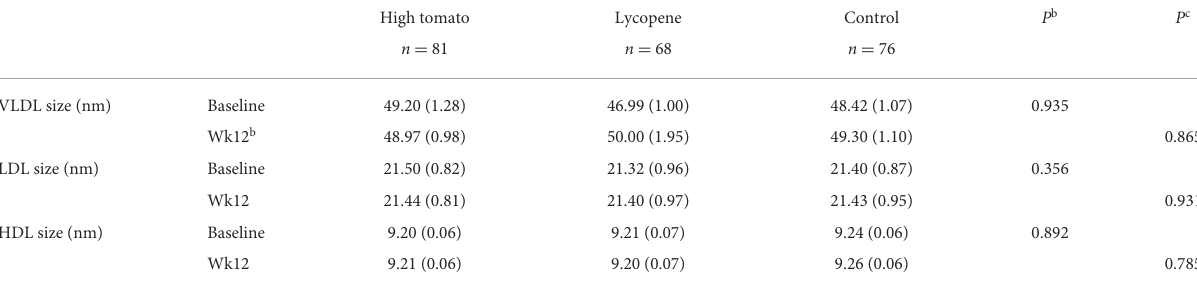
TABLE 9 Lipoprotein size in response to 12-week intervention with high tomato, lycopene, and control diets a . High